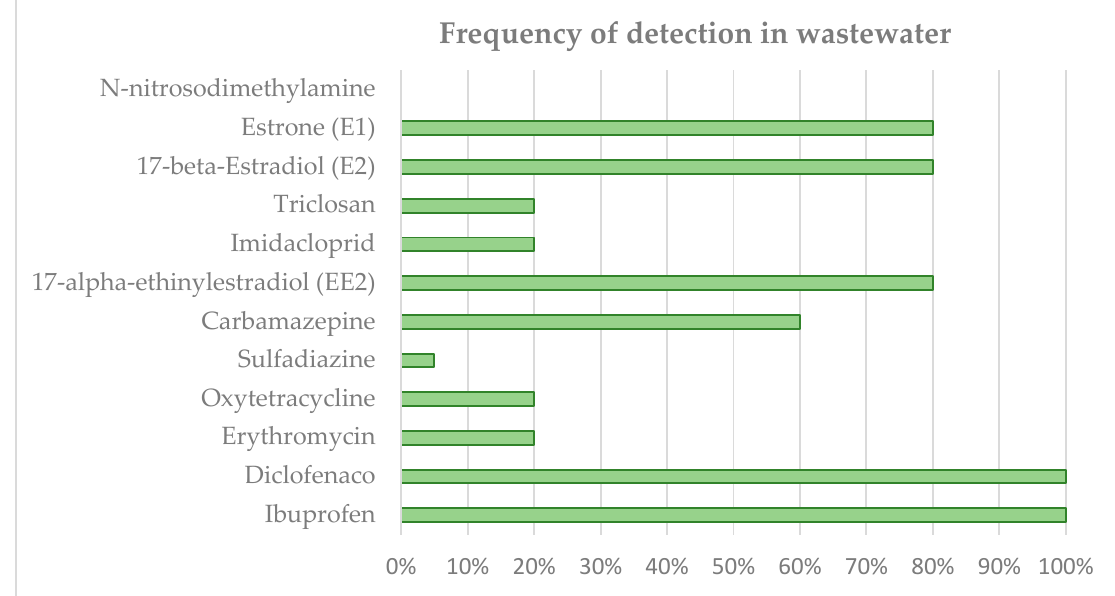
0% Figure 6. Frequency of detection of emerging pollutants at the inlet of WWTP A. Figure 6. Frequency of detection of emerging pollutants at the inlet of WWTP